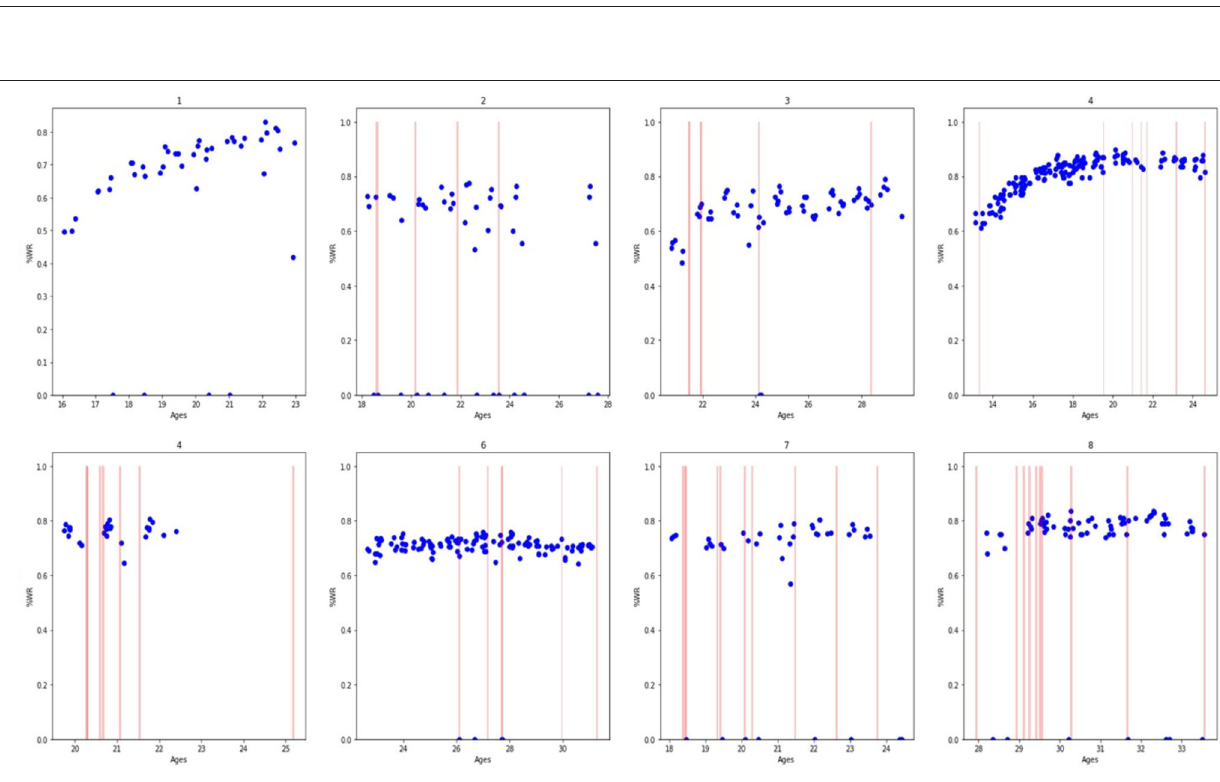
Frontiers in Sports and Active Living |